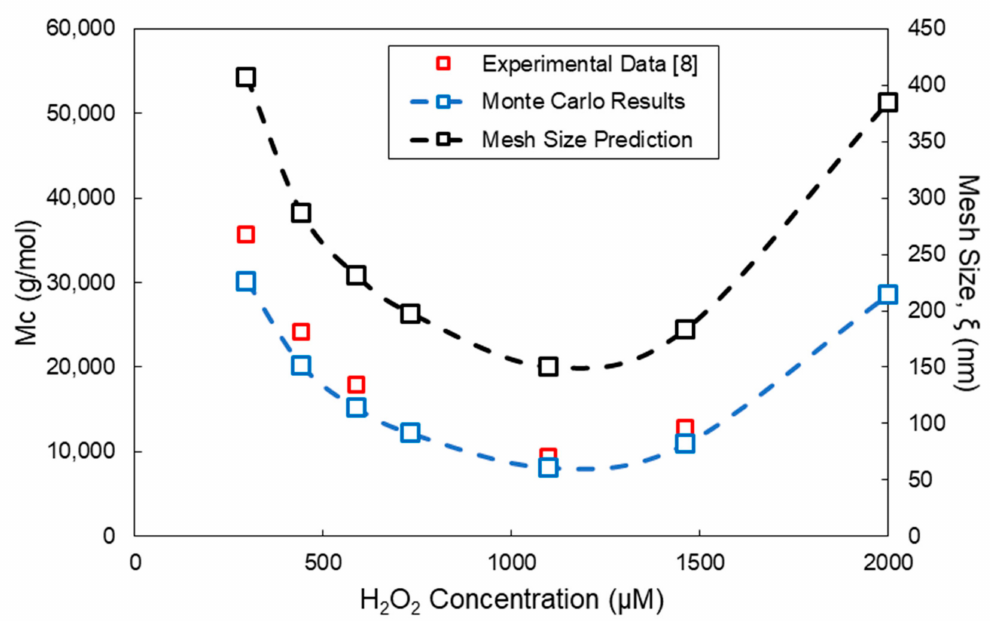
Figure 11. Effect of the H 2 O 2 concentration on the molecular weight between crosslinks, M c , for the HA-Tyr crosslinkable solution (i.e., 1.75% w/v , MW = 90 kDa and HRP concentration = 0.062 units/mL). All MC simulations were conducted with an initial polymer chains population of ~ 10 6